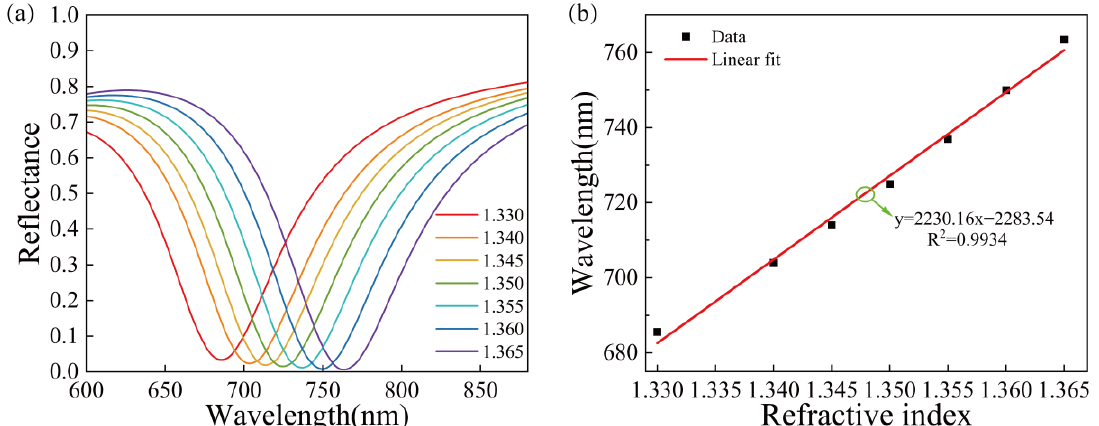
Figure 5. The reflectance curves of the Au/SiO 2 thin film structure, ( a ) SPR curves for different refractive indices of the Au/SiO 2 thin film structure, ( b ) relationship between refractive index and resonance wavelength and the linear fitting.